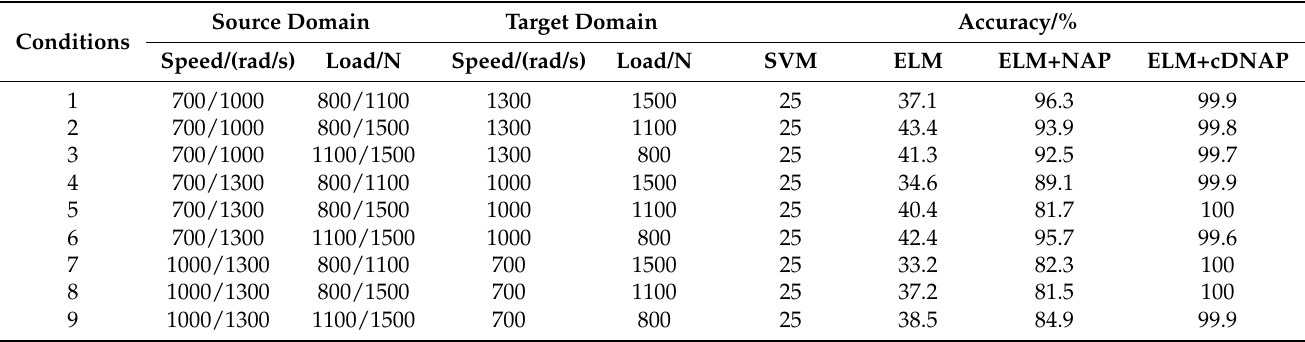
Table 3. Fault diagnosis results of compound working